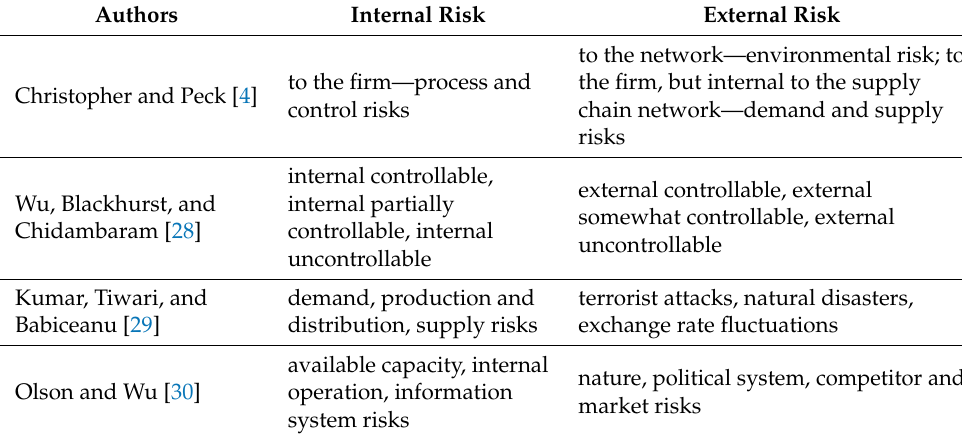
Table 1. Examples of the risk